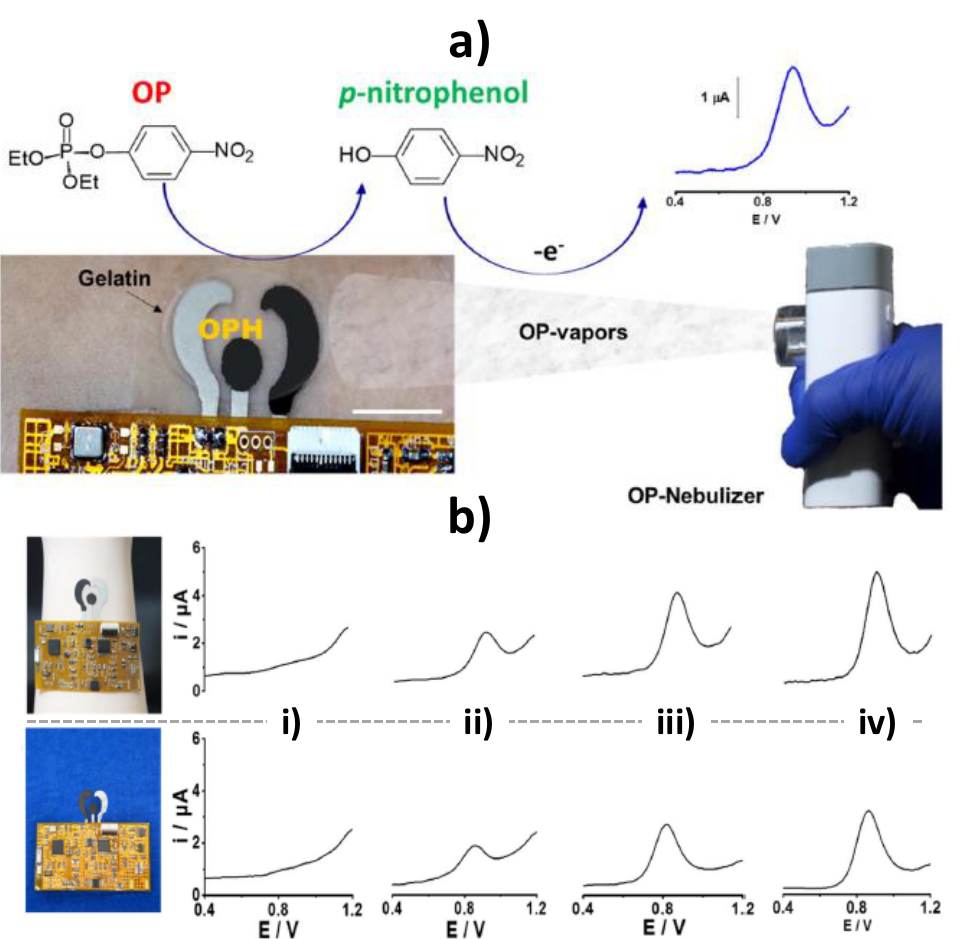
Figure 10. Epidermal tattoo organophosphorus hydrolase (OPH)-based biosensor for vapor-phase detection of OP through SWV measurements of the p-nitrophenol generated after interaction of the MPOx micro-droplets released from the nebulizer with the OPH layer ( a ). Pictures of the OPH based epidermal tattoo (up) and textile (down) biosensors integrated with the flexible electronic interface and SWV responses they provide upon spraying 0 (i), 5 (ii), 10 (iii), and 15 (iv) mM MPOx in the vapor phase ( b ). Reprinted and adapted with permission of Elsevier [82].